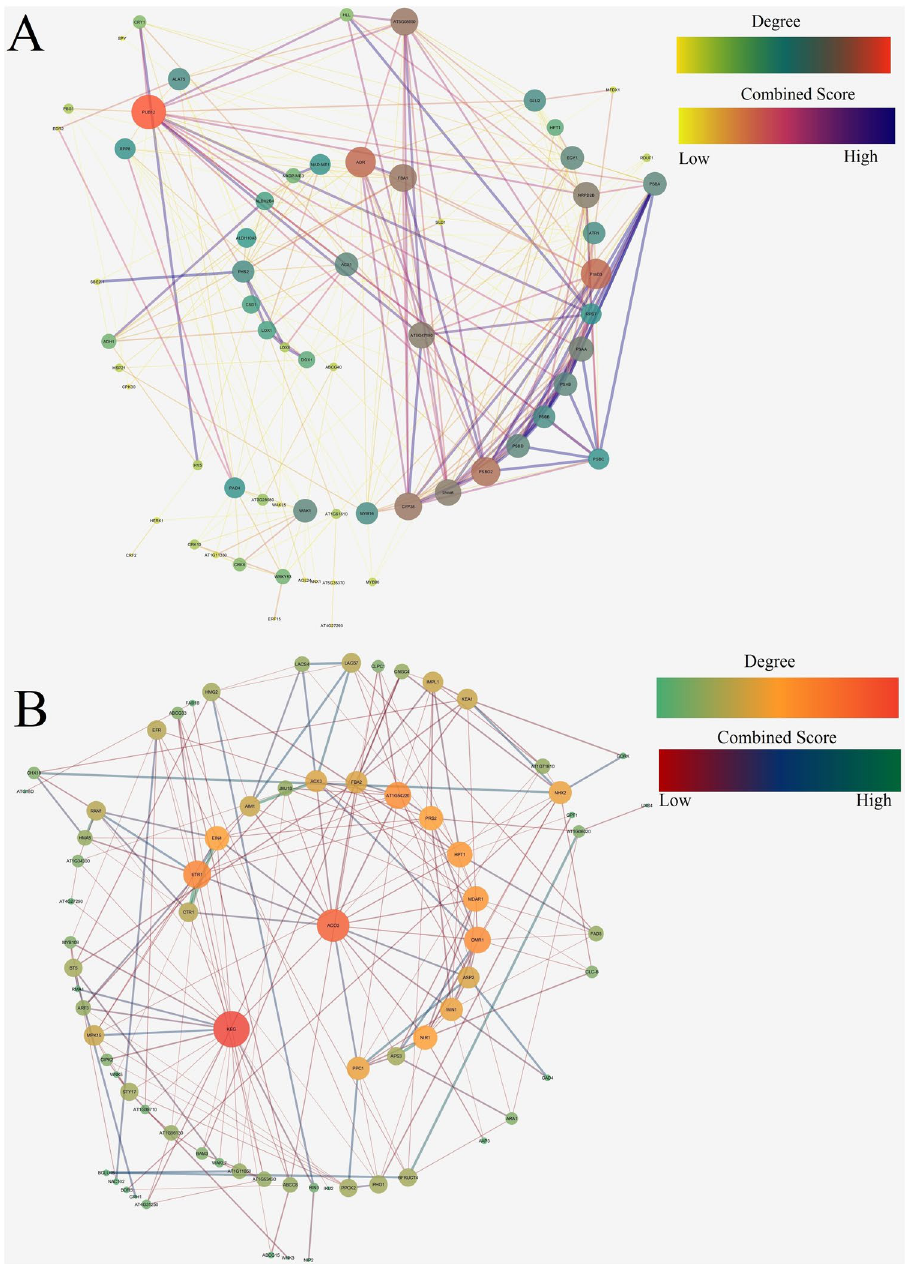
Figure 13. Topological networking of STRING (second round) generated up-regulated ( A ) and down- regulated ( B ) gene interaction data using Cytoscape platform (version 3.7.1; https:// cytos cape. org/). For up-regulated genes Cytoscape connected 65 nodes with network density and homogeneity of 0.143 and 0.613 respectively, with characteristic path length of 2.480 and average number of neighbours of 9.169. For down- regulated genes Cytoscape connected 74 nodes with network density and homogeneity of 0.080 and 0.690 respectively, with characteristic path length of 2.785 and average number of neighbours of